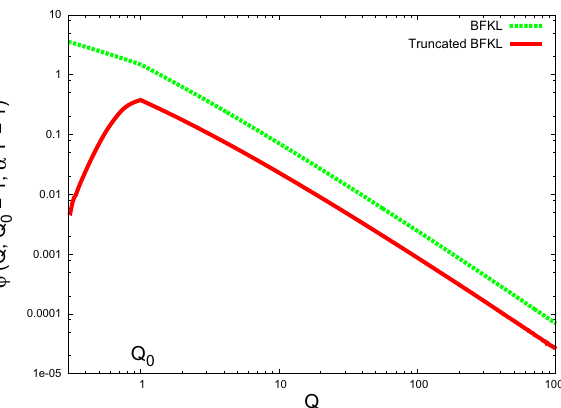
Fig. 16 The BFKL and the truncated BFKL kernels in γ space